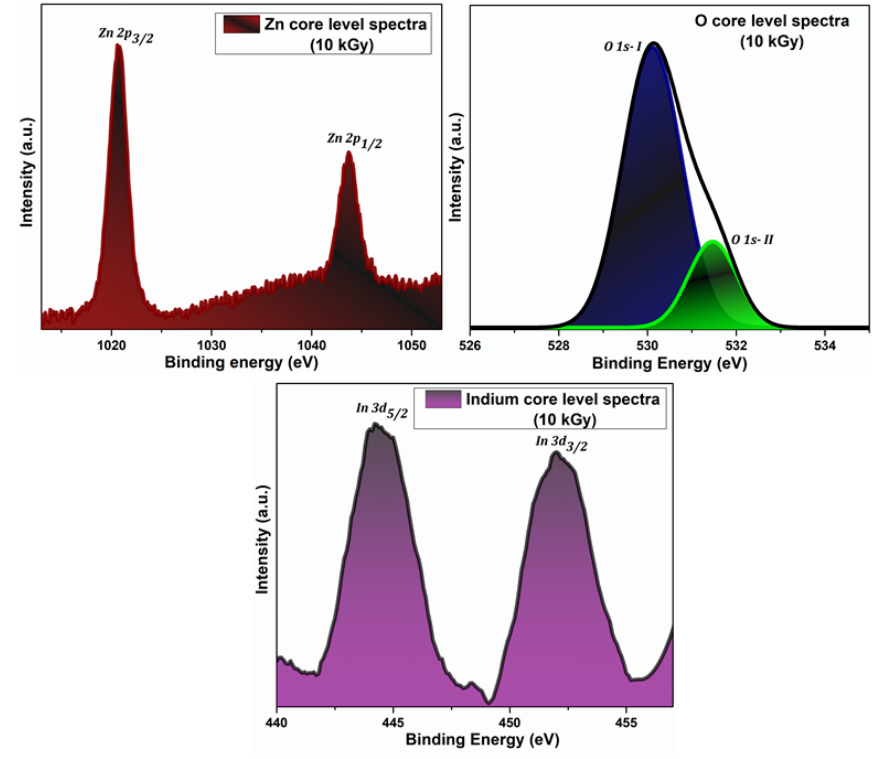
Figure 5. XPS core level spectra of Zn, O, and In.